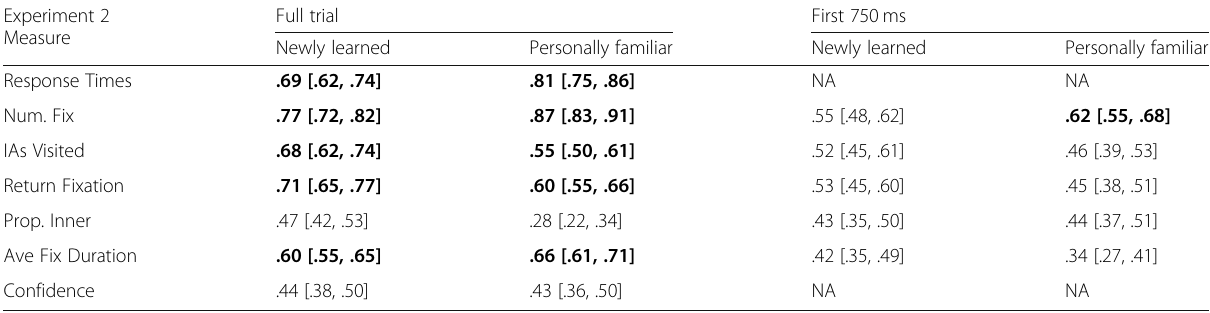
Table 2 Areas under the curve [95% CIs] calculated for all markers of recognition in Experiment 2 for the full trial period and first 750 ms of the trial. Numbers in bold indicate AUCs above chance (i.e. the lower bound limit CI exceeds